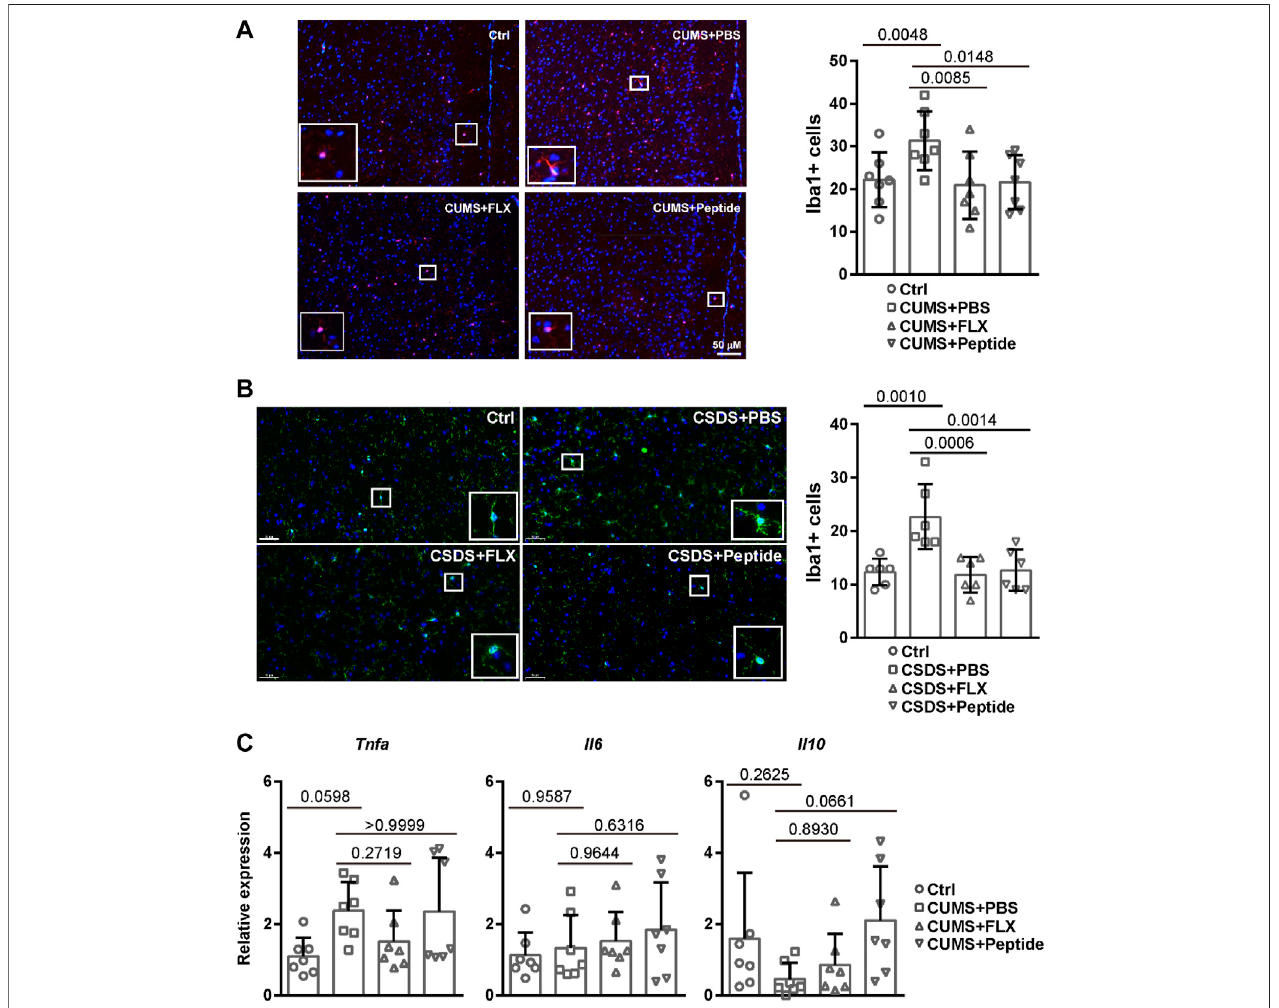
FIGURE 5 | ARA290 reduced CUMS- and CSDS-induced microglia activation: 8-week-old male C57BL/6 mice subjected to the CUMS model ( n = 7 mice per group) (AandC) or5-week-oldmaleC57BL/6micesubjectedtotheCSDSmodel( n =6micepergroup) (B) weretreatedwith fl uoxetine(FLX)orARA290(peptide)daily. Theprefrontal cortexcoronal sectionsweresubjectedtoimmuno fl uorescence stainingofIba1(scalebar,50 μ M).DAPIwasused asamarkerforthenucleus (Aand B) . ThemRNAlevelsofin fl ammatorycytokinesintheprefrontalcortexweredeterminedbyquantitativeRT-PCR (C) .Thestatisticalvaluesbetweendifferentgroupsare